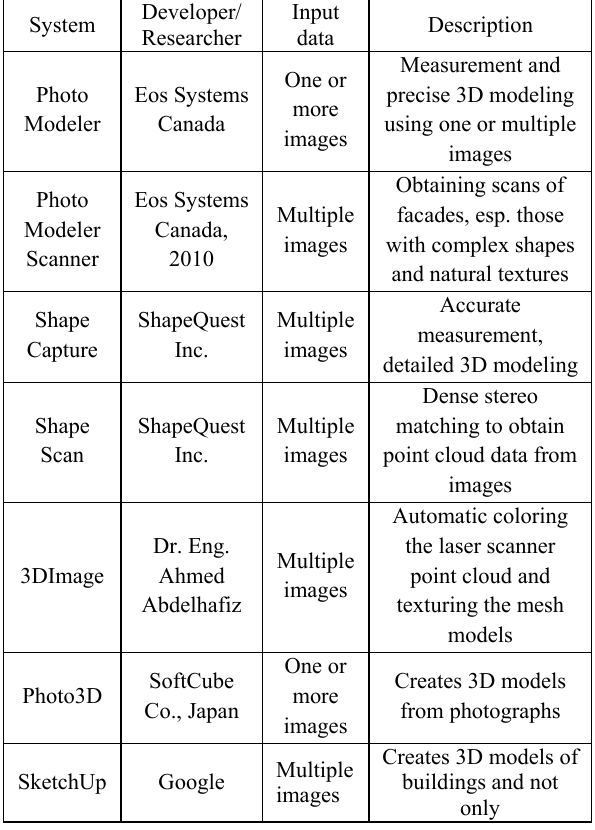
Table 1 . Some of the existent commercial software for 3D textured models creation using photographs